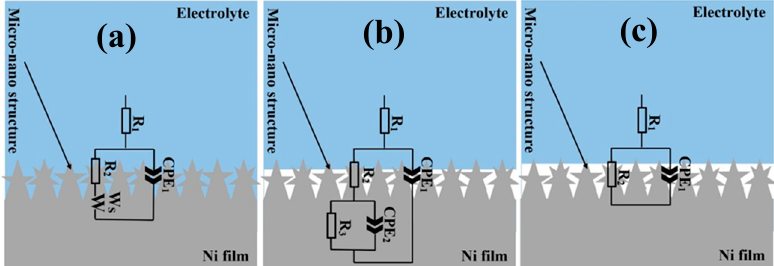
Figure 6. Equivalent circuits models superimposed on schematic representations of ( a ) Samples D12 and D25 before functionalization, ( b ) functionalized D12, and ( c ) functionalized D25 in solution. ( a – c ) Micro- and nanostructures schematically presented out of scale.